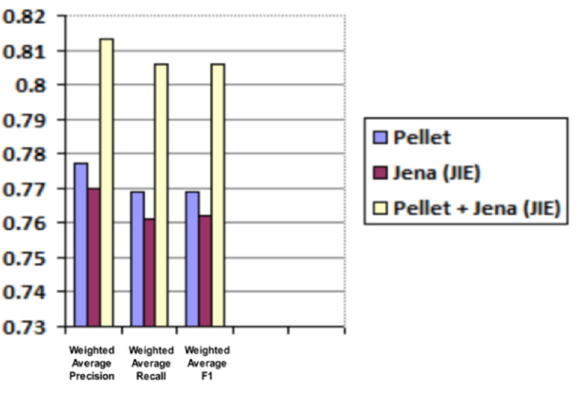
Figure 13. Predicted roles evaluation (average precision, recall and F1). Table 4. Predicted roles evaluation (weighted average values for precision, recall and F1).